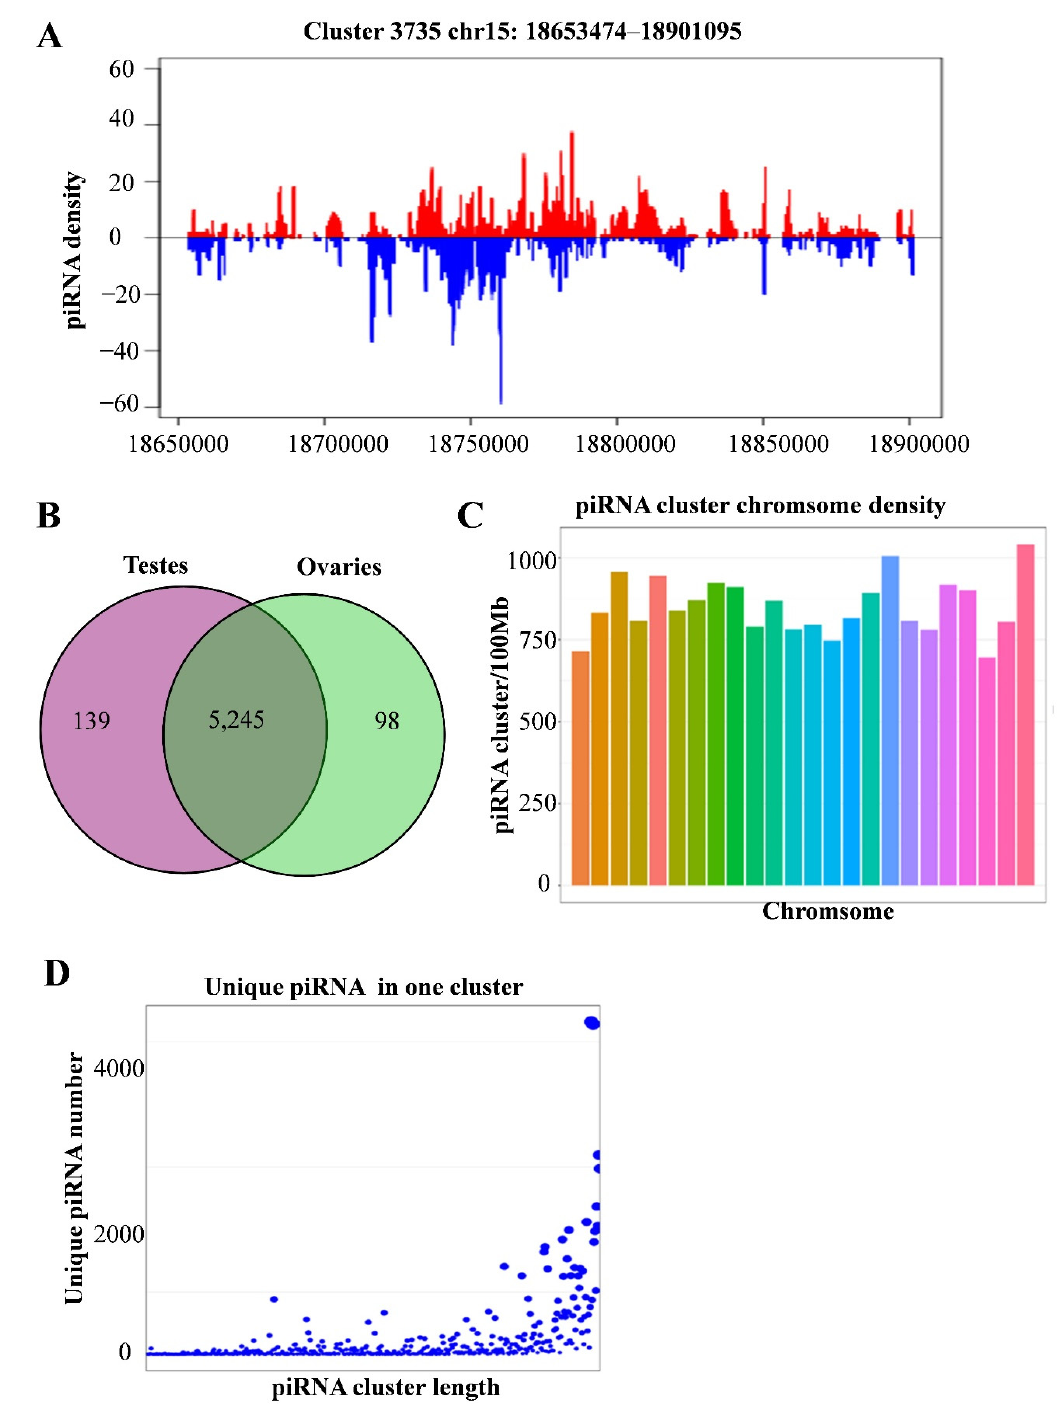
Figure 5. Characteristics of piRNA clusters. ( A ) piRNA density of cluster 3735, which has the largest clusters. ( B ) Venn diagram showing shared and unique piRNA clusters in the testes and ovaries. ( C ) Chromosome distribution of piRNA clusters. ( D ) Number of piRNAs in each piRNA cluster.